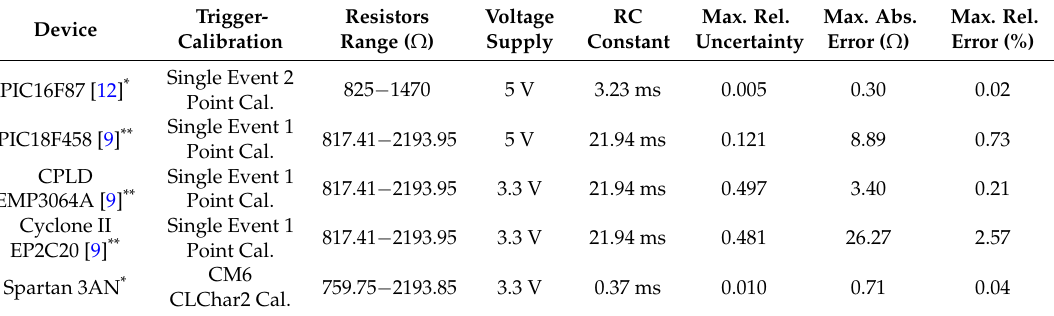
Table 5. A comparison between this proposal and other implementations for the resistors range of PT-1000 temperature sensor ( * worst case, ** averaging 500